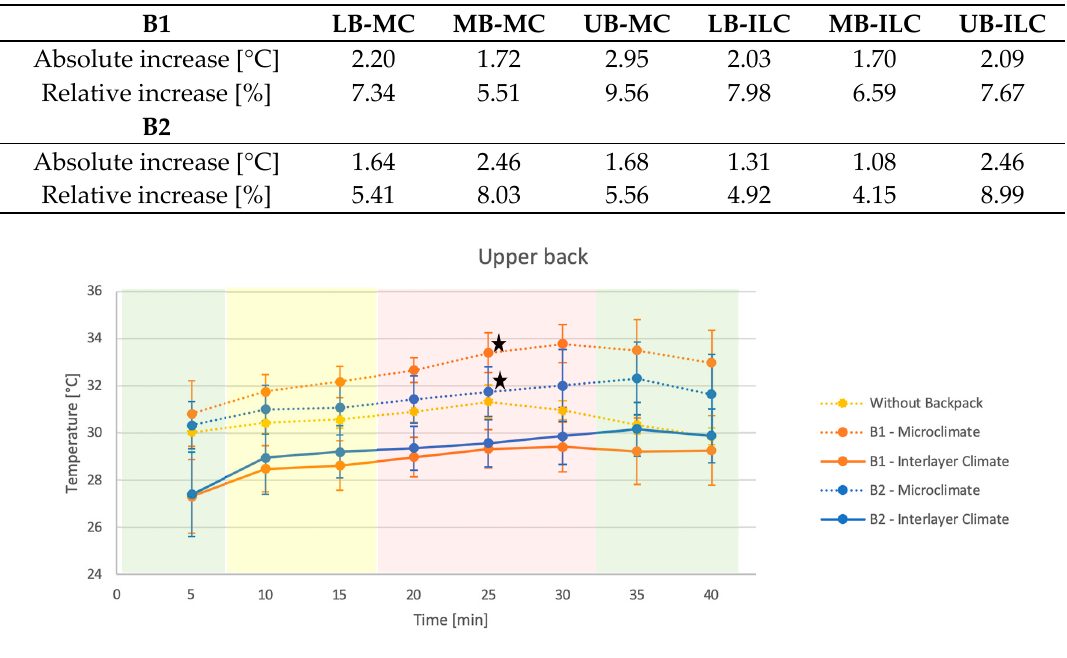
Figure 4. Mean values with standard deviation of the temperature at the UB in the MC without backpack (yellow-dotted), with B1 (orange-dotted) and B2 (blue-dotted) as well as in the ILC with B1 (orange-straight) and B2 (blue-straight). Acclimatization (green), walking at v = 4 km/h (yellow), walking at v = 4 km/h and 8% incline (red). ★ significant